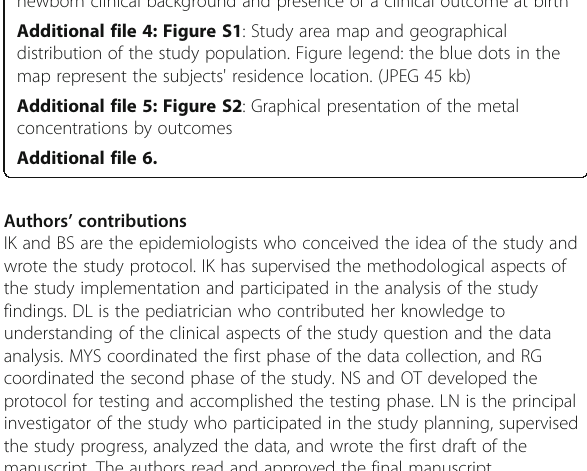
Additional file 1: Table S1 : Demographic characteristics and clinical outcomes in the study population and the initial cohort, Clalit HMO members